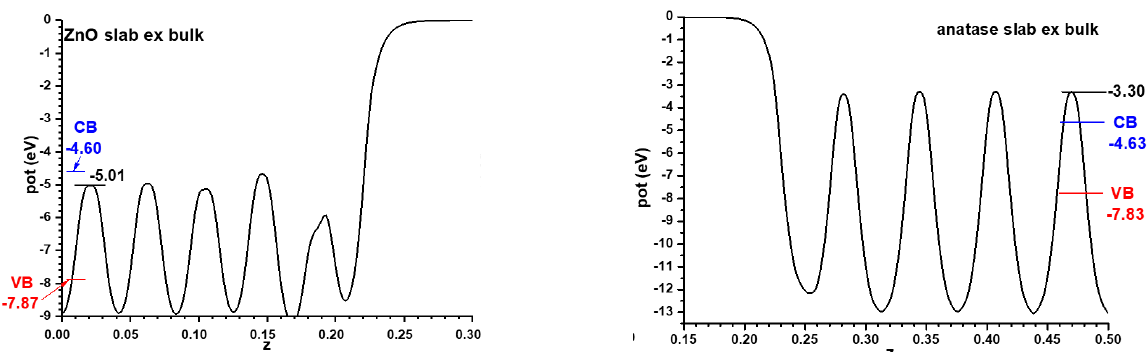
Figure 2. The Hartree potential profile for slabs, facing the vacuum, of ZnO (11 cation planes) and anatase (9 cation planes), indicating for this model the positions in each case of the VB and CB as transferred from the results of Figure 1. These Hartree potential profiles are displayed for only one half of the unit cells.